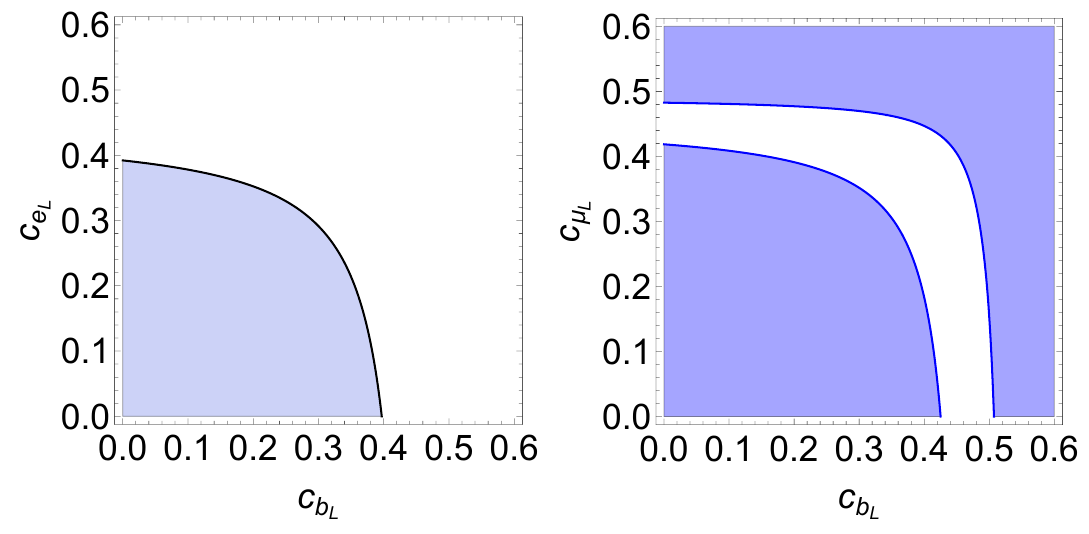
; c e ) that accommodates the constraint on L L b L ; c (cid:22) L ) that accommodates the